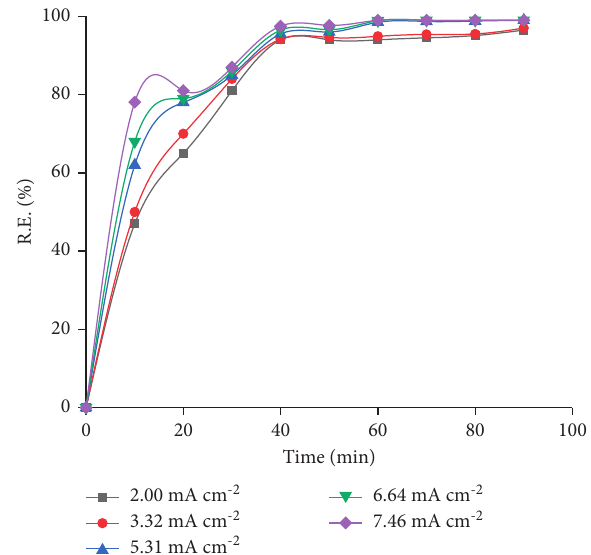
Figure 5: Current density’s influence on the efficiency of